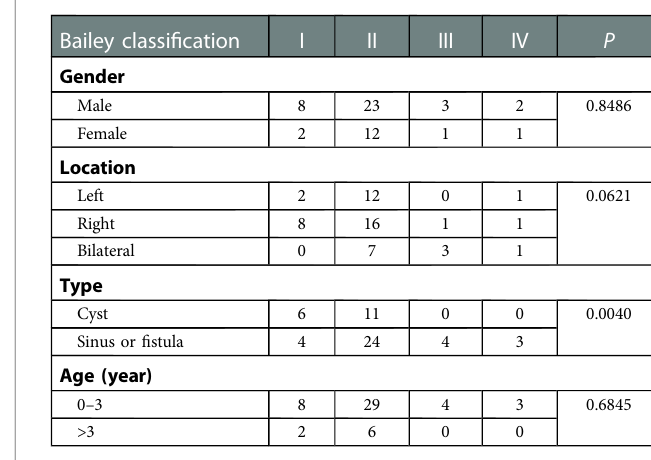
TABLE 2 Statistical analysis for gender, location, type, age, and Bailey classi fi